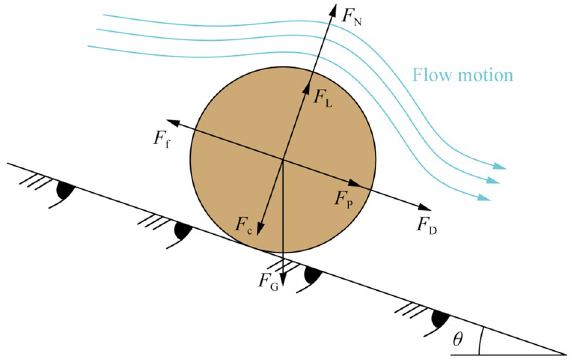
Figure 1. Force analysis for a single particle on the surface of a soil